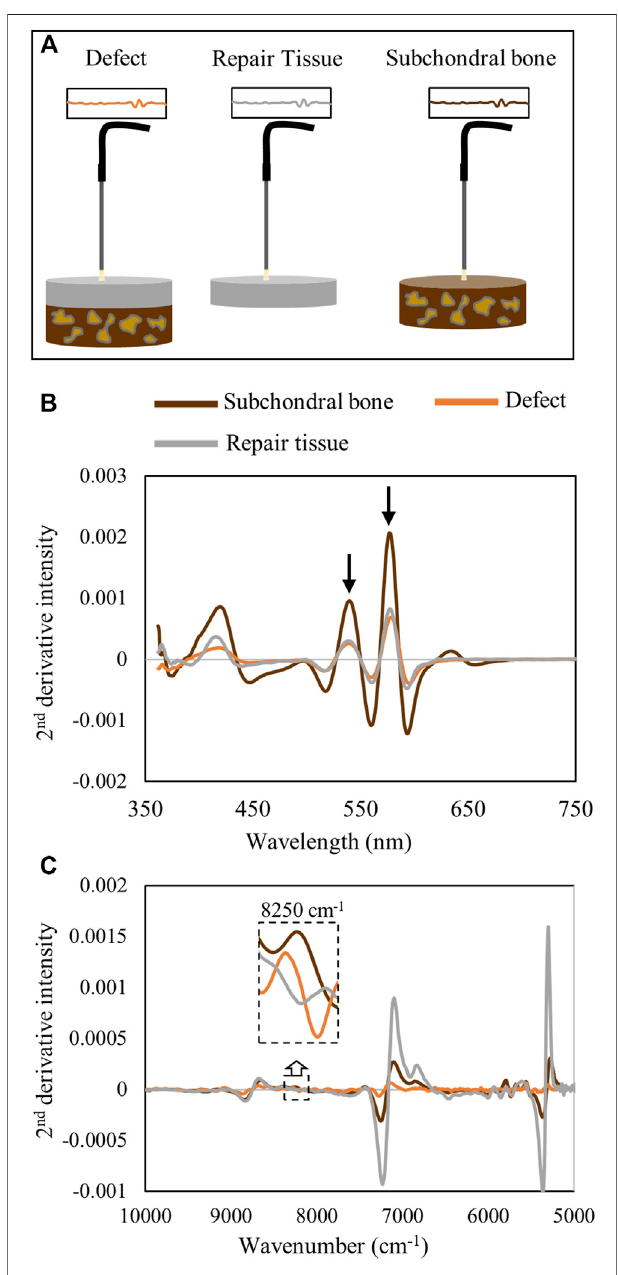
FIGURE 8 | (A) Schematic of data collection from the defect tissue ( in situ ) and individual components, repair tissue,and subchondralbone, ex vivo . (B) Second-derivative spectrafrom thedefect in situ and isolated repair tissue and subchondral bone ex vivo in the visible range demonstrate the hemoglobin peak intensities at 540 and 570 nm in the defect tissue are more similar to those in the repair tissue than to those in subchondral bone. (C) Second-derivativespectraintheNIRregiondemonstratethedifferencesinthe water absorbances in the repair tissue in ex vivo compared to in situ spectra. At 8250 cm − 1 , the in fl uence of subchondral bone on the in situ defect spectrum is apparent while absent in the isolated repair tissue spectrum.